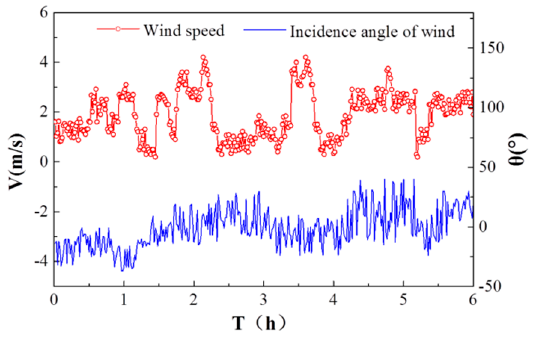
Figure 10. Wind field during the observation. Appl. Sci. 2019 , 9 , x FOR PEER REVIEW